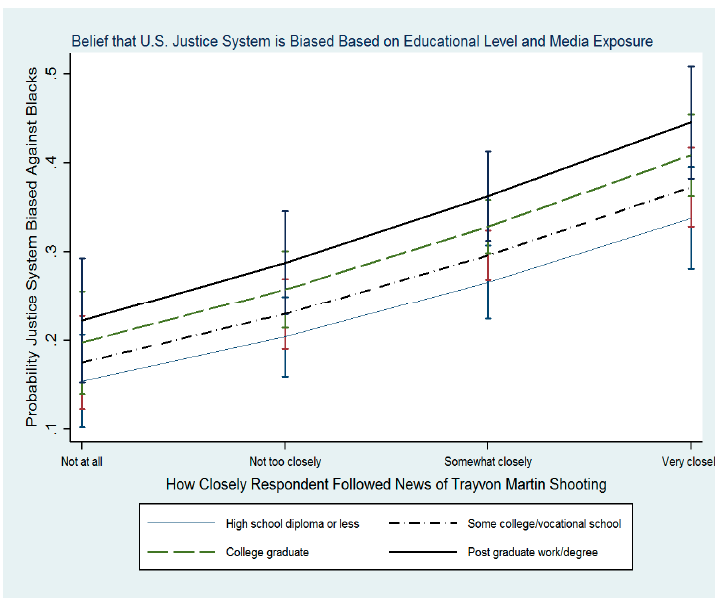
Figure 7. Respondents Perceptions of Bias Based on Media Exposure and Education Level.